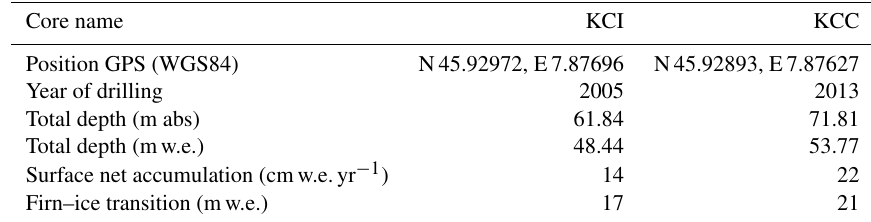
Table 1. Basic glaciological parameters of the two CG ice cores.